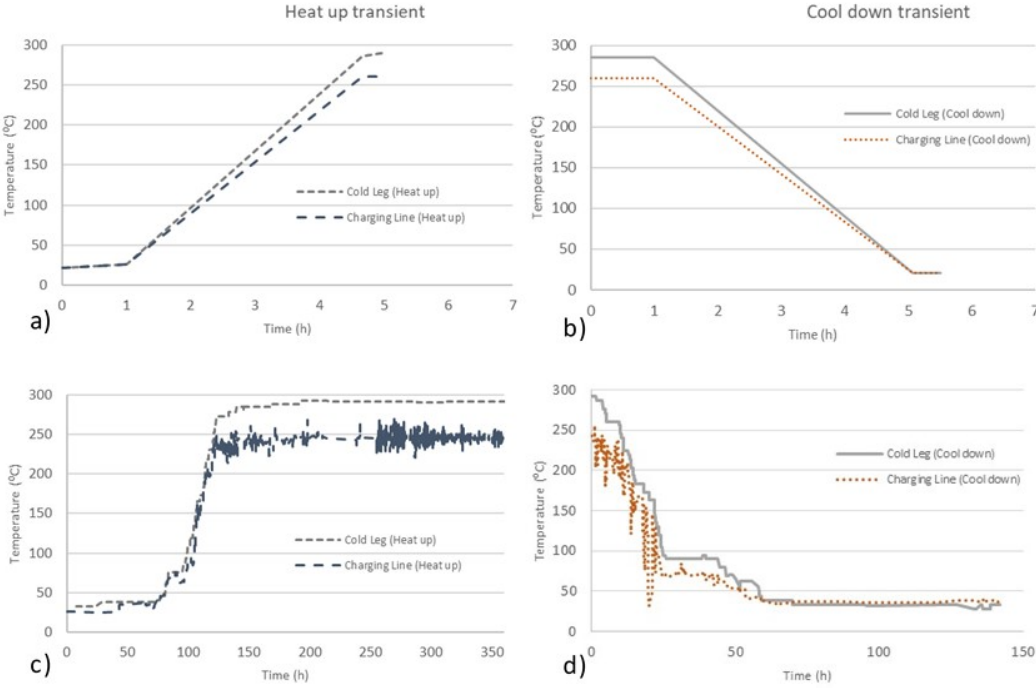
Figure 5. Temperature evolution in both the cold leg and the charging line during design and in-plant transients. ( a ) Design heat-up; ( b ) design cool-down; ( c ) in-plant heat-up; ( d ) in-plant cool-down.